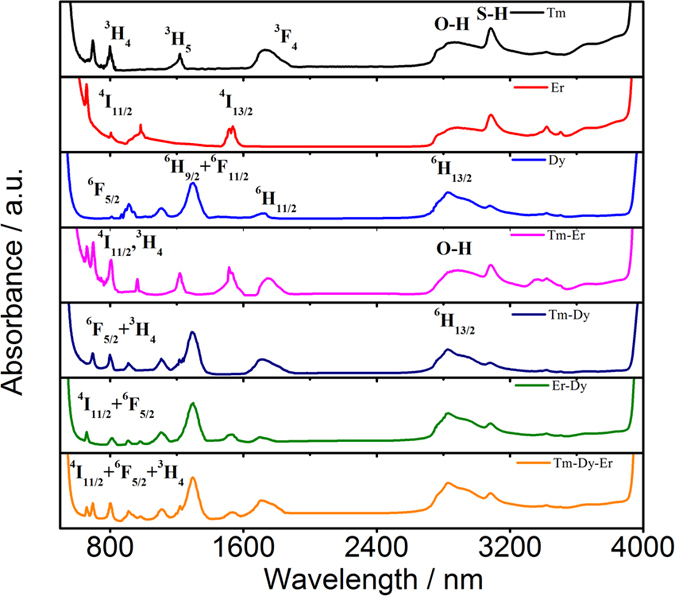
The absorption spectra of singly-, co-, and triply-doped 65GeS2–25In2S3–10CsI glass (thickness of 2 mm) at room temperature.